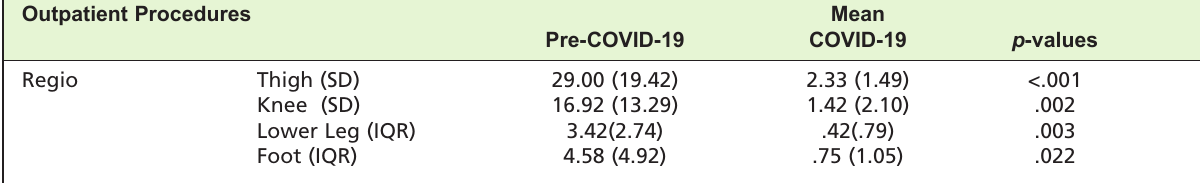
Table IV: Total outpatient visits in pre-COVID-19 and COVID-19 period by